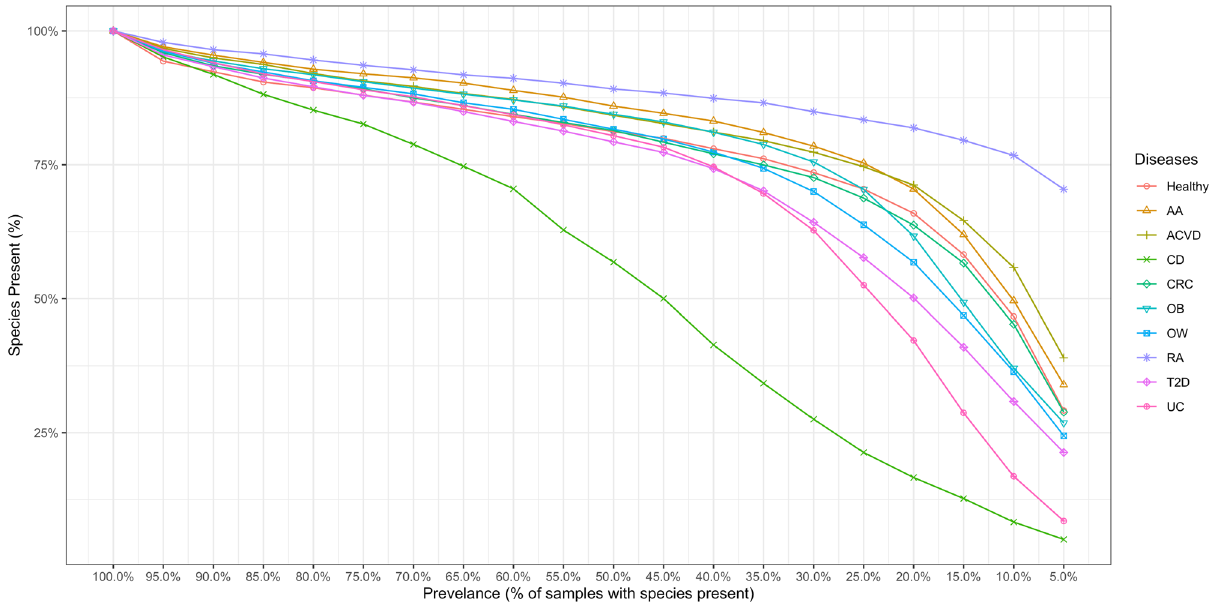
Figure 1. Identified species retained decreases with increasing prevalence threshold. The X-axis represents the prevalence threshold to filter species at in increments of 5%. The Y-axis represents the proportion of species represented in a given disease phenotype abundance